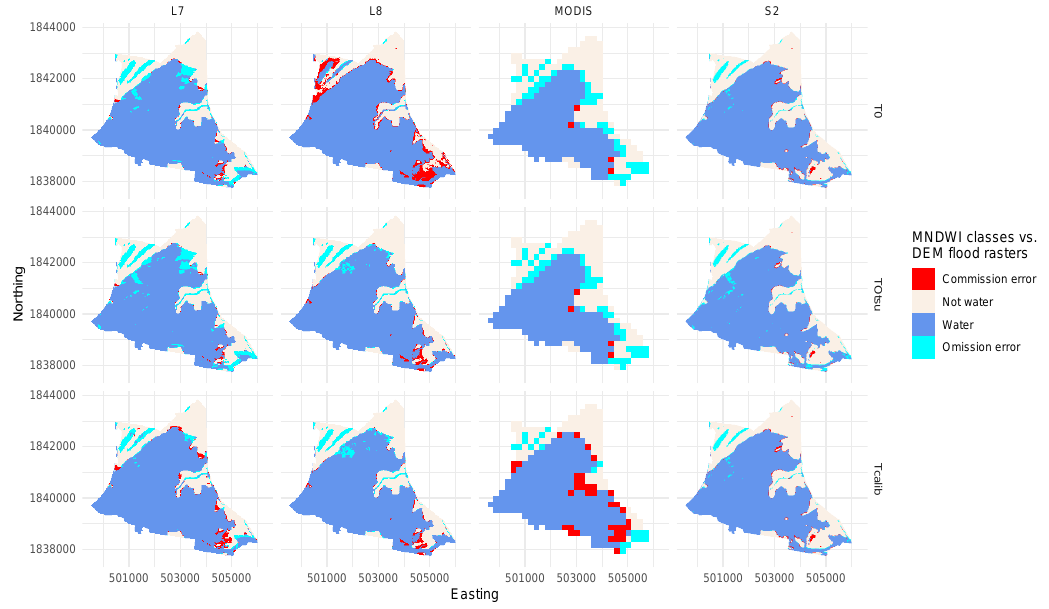
Figure 9. MNDWI classifications from four sensors based on three thresholding methods during a high flood, October